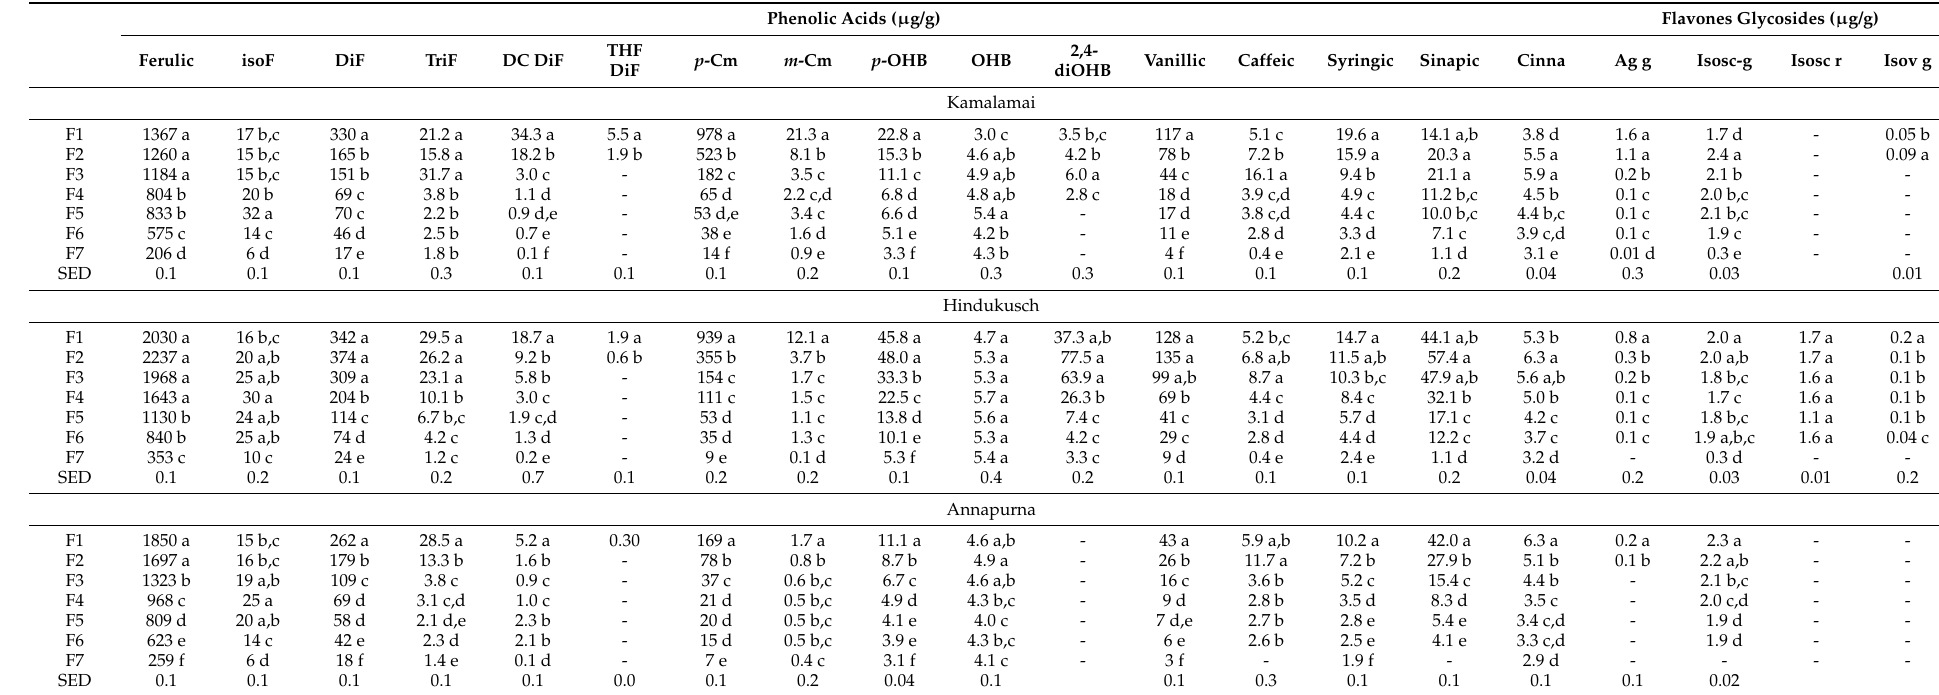
Table 5. Bound phenolic compounds contents ( µ g/g) in barley pearling